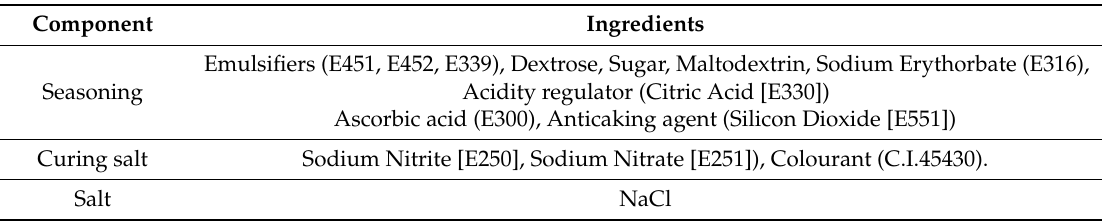
Table 1. Ingredients of the brine (Ref: 01124015) used (Deli SpicesTM). Component Ingredients